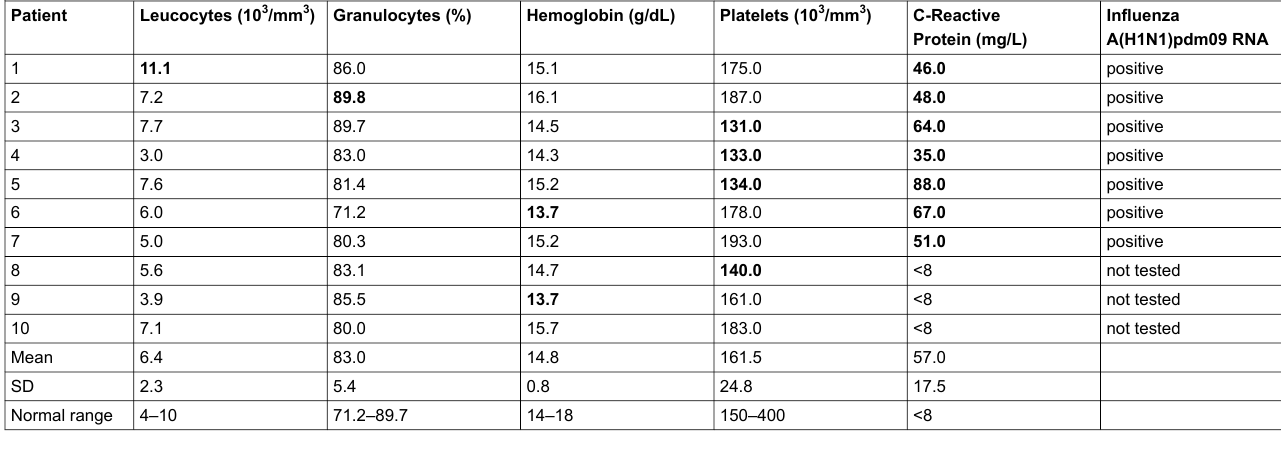
Table 2: Laboratory results of 10 patients with high fever (>39.5 °C). Seven patients were among the 16 patients tested for A(H1N1)pdm09. Patient